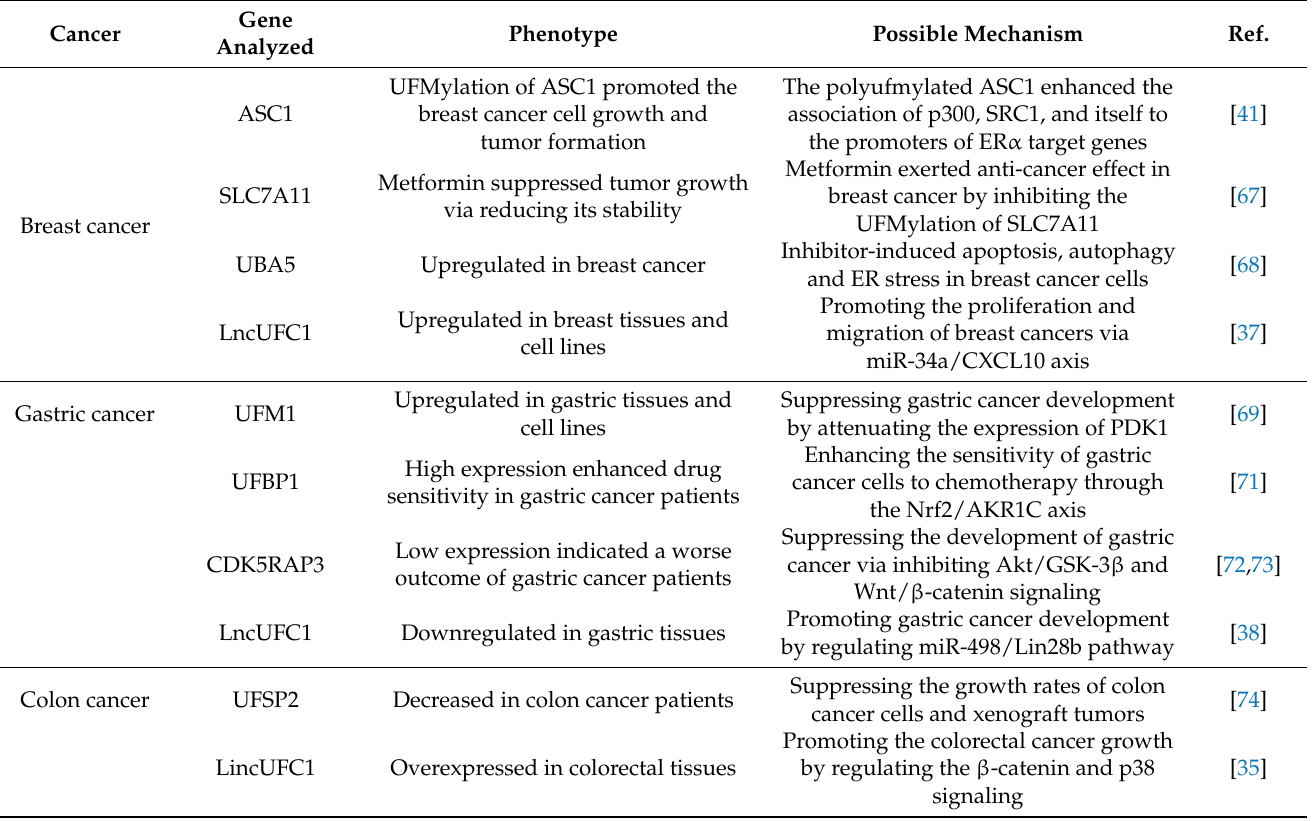
Table 1. The role of UFM1 modification in various